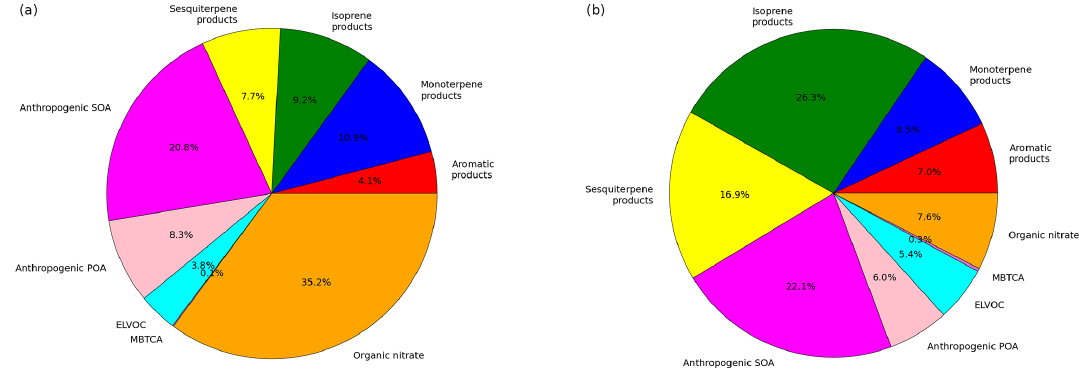
Figure 8. Simulated chemical composition of OM 1 on 16 July (a) and on 30 July 2013 (b) .